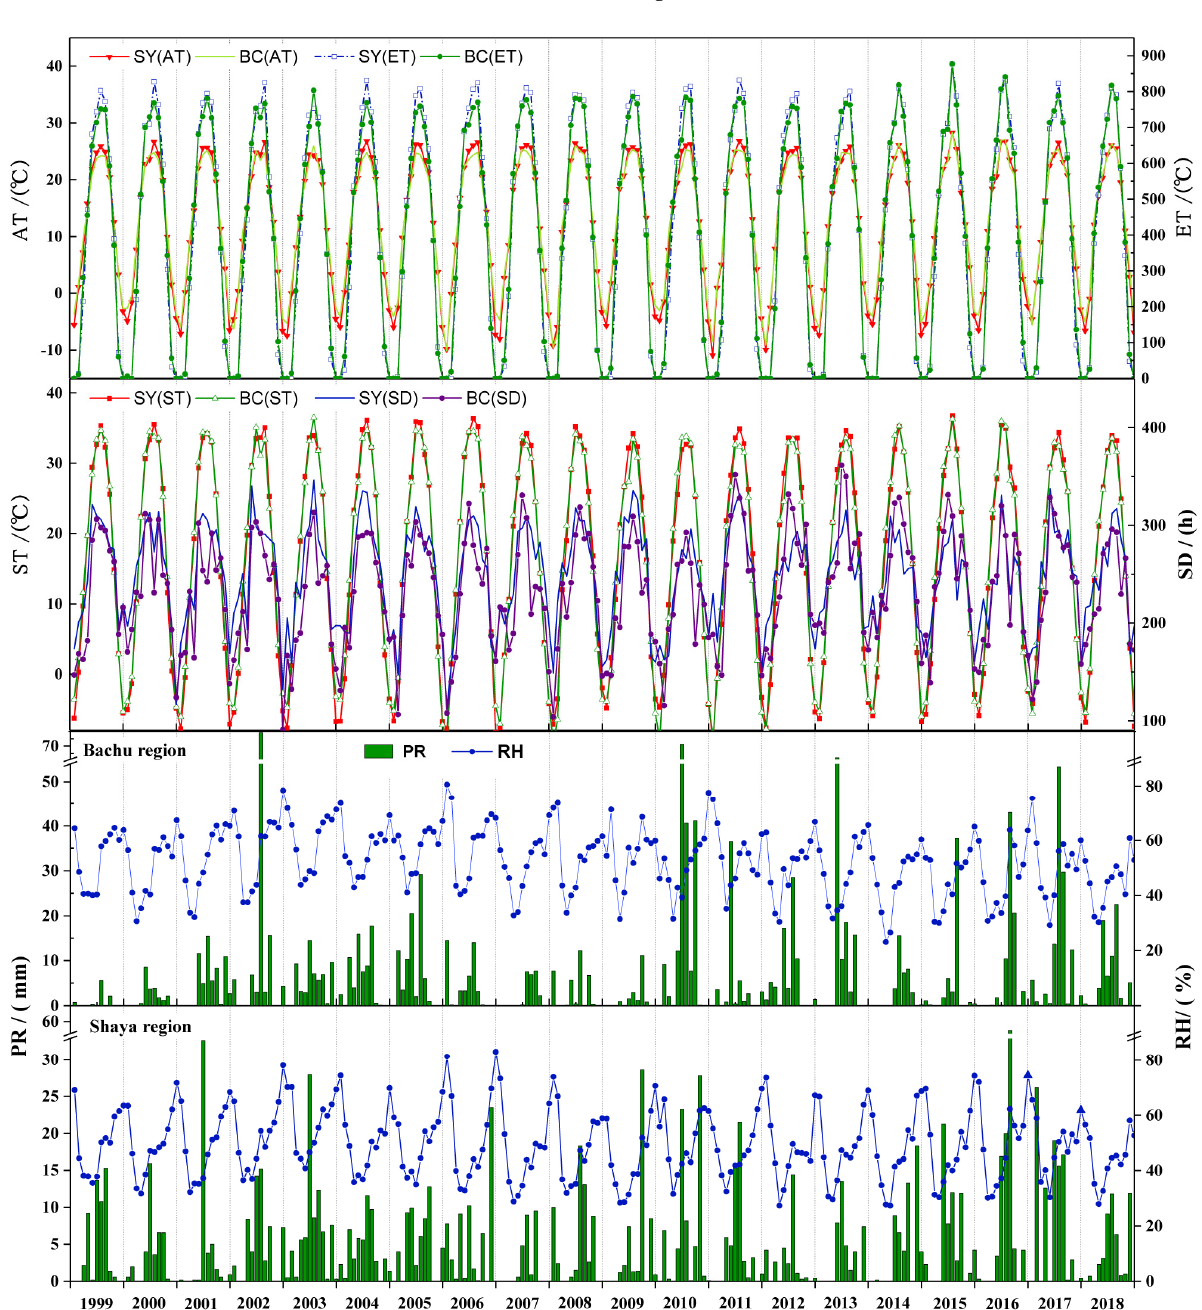
Figure 4. Sunshine duration (SD), average air temperature (AT), average land surface temperature (ST), effective accumu- lated temperature (EA), average relative humidity (RH), and precipitation (PR) time series from 1999–2018 in Bachu region (BC) and Shaya region (SY).